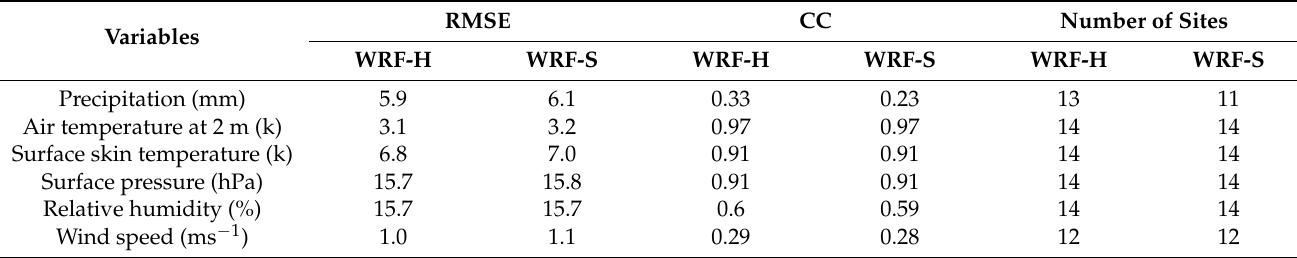
Table 3. Averaged Root-Mean-square Error (RMSE) and Correlation Coefficient (CC) between the measurements collected from the 14 China Meteorological Administration (CMA) stations and the simulated near-surface and land surface meteorological variables for the period from 15 July 2009 to 30 November 2018. The last column is the number of sites that passed the significance test across the 14 observatories. RMSE Variables Precipitation (mm) Air temperature at 2 m (k) Surface skin temperature (k) Surface pressure (hPa) Relative humidity (%) Wind speed (ms − 1